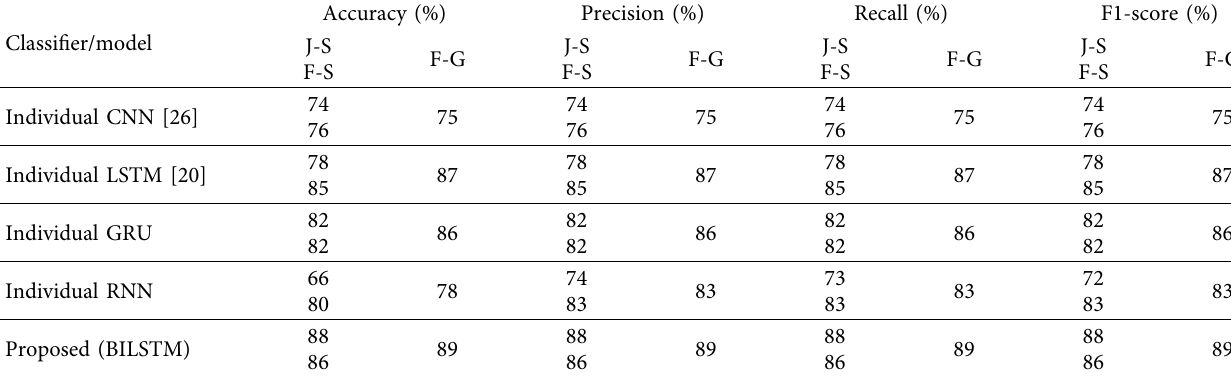
Table 8: Evaluation results of variant deep learning and the proposed technique.